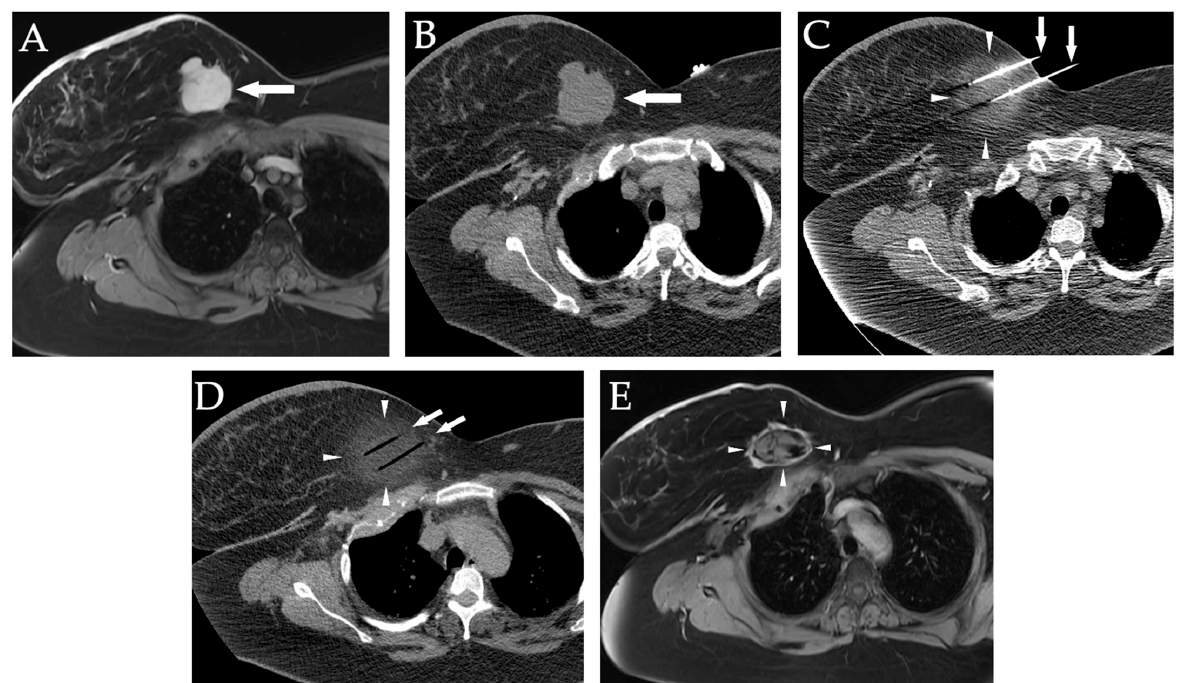
Figure 18. Right breast sarcoma treated with CT-guided cryoablation. ( A ) Axial gadolinium-enhanced T1-weighted, fat-suppressed MR image shows a lobulated right breast sarcoma mass (white arrow). ( B ) Axial pre-cryoablation, non-enhanced CT image shows target lobulated right breast lesion (white arrow). ( C ) Axial non-enhanced CT image during cryoablation shows two cryoprobes (white arrows) traversing the target lesion (white arrowheads). The lesion is less visible having become nearly iso-dense to fat due to freezing. ( D ) Axial non-enhanced CT image at the conclusion of cryoablation shows the two cryoprobe-ghost trajectories (white arrows) after the probes were removed (white arrowheads). ( E ) Axial gadolinium-enhanced T1-weighted, fat-suppressed MR image 2-years after cryoablation, shows a shrinking, non-enhancing, necrotic lesion surrounded by a thin rim of fibrous tissue (arrowheads).